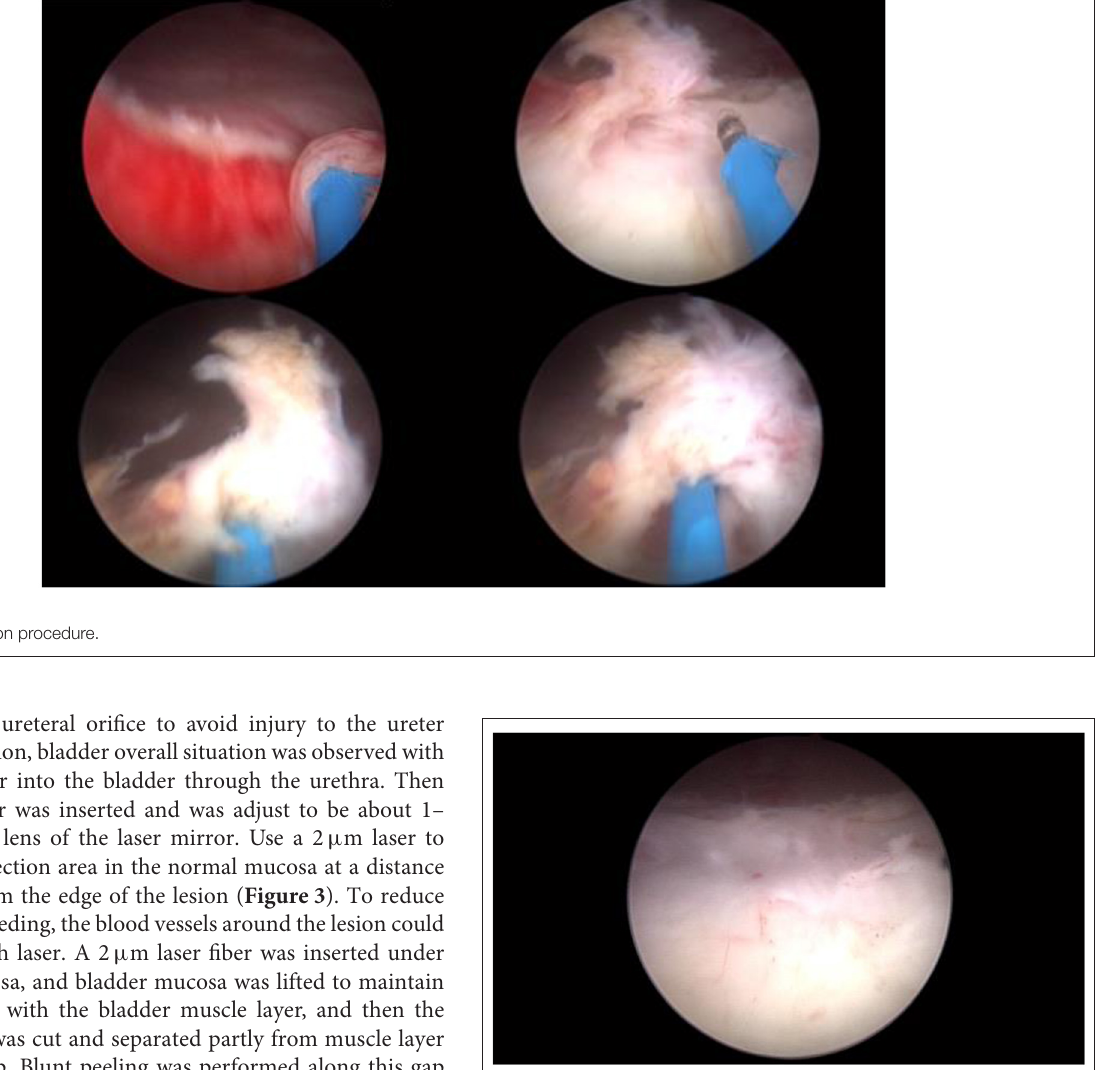
FIGURE 5 | En bloc resection bladder